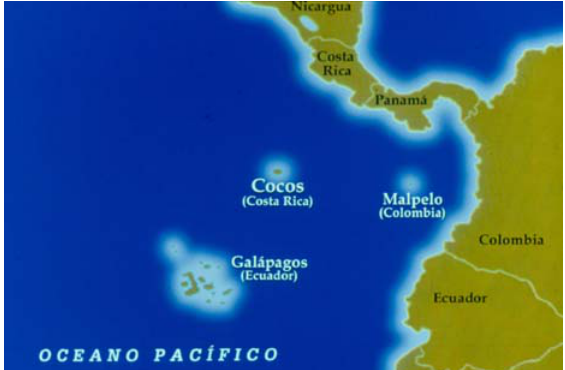
Figure 1 . Cocos Island (Isla del Coco) is a Costa Rican protected insular territory located in the Tropical Eastern